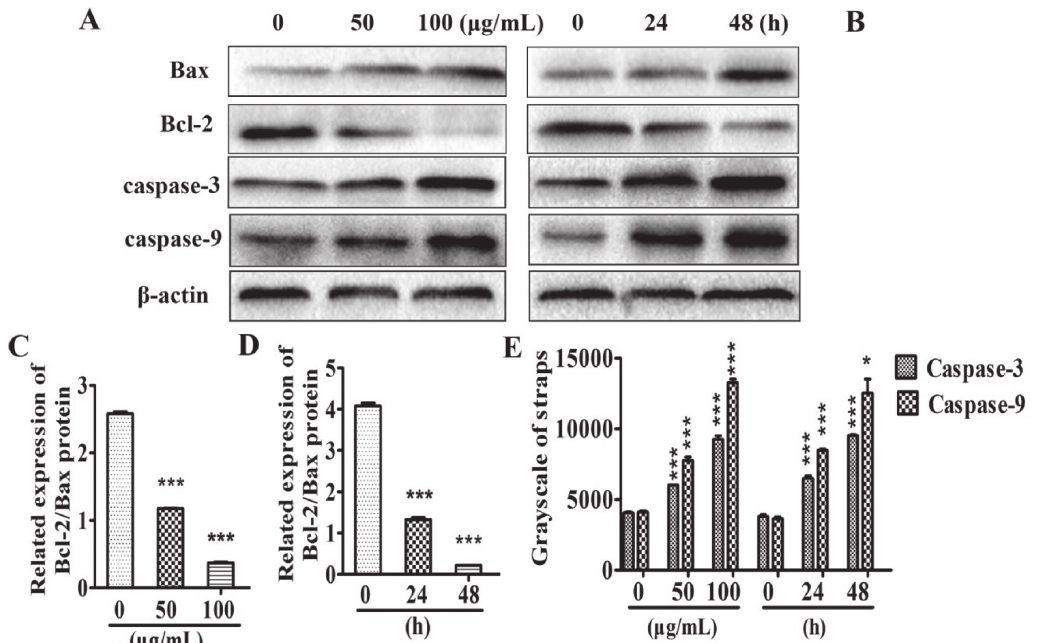
FIGURE 5 - (A) HepG2 cells were cultivated with 0, 50 and 100 μg/mL of EEEO for 24 h, and (B) incubated for 0, 24 and 48 h with 50 μg/mL of EEEO, respectively. And then Bax, Bcl-2, caspase-3, caspase-9 and β-actin were assessed via Western blotting. (C, D) Bcl-2/Bax ratio and (E) quantification of caspase-3 and caspase-9 were analyzed and expressed. 0 μg/mL (or 0 h) of EEEO treatment served as control group. Statistical analysis was tested at significance * P < 0.05 and *** P < 0.001 compared to untreated